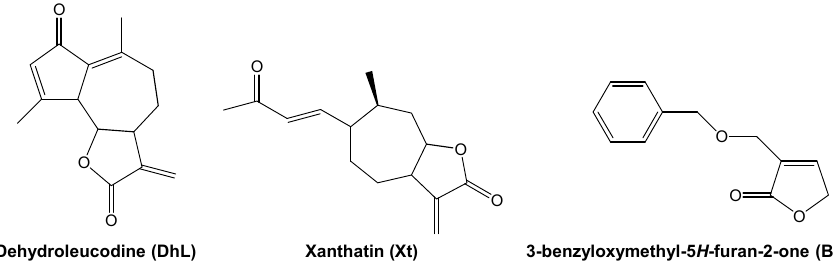
Figure 1. Chemical structure of dehydroleucodine, xanthatin and 3-benzyloxymethyl-5 H -furan-2-one.